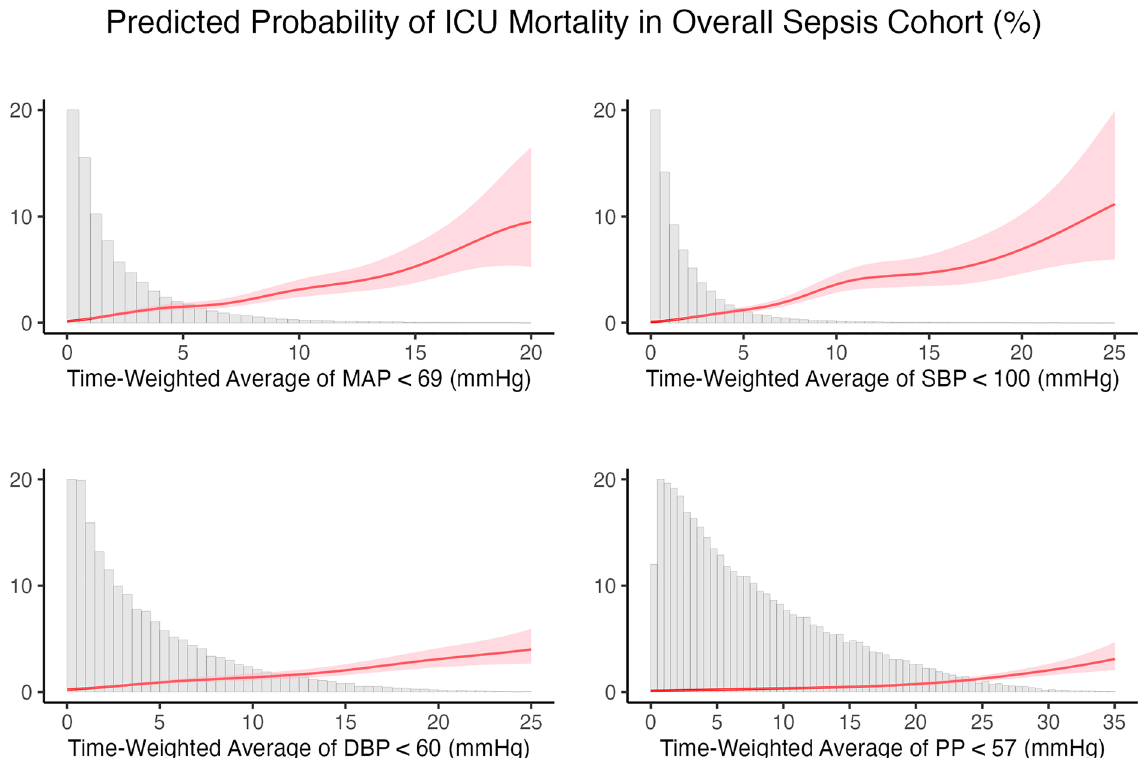
Fig. 4 Relationship between time-weighted average and ICU mortality in overall sepsis